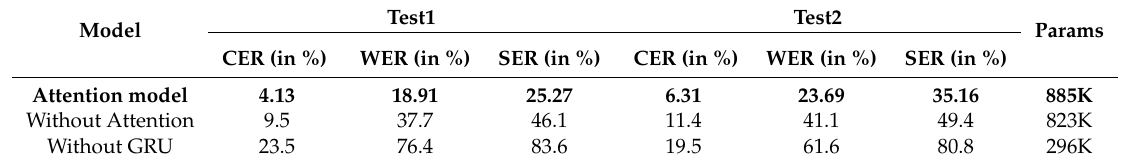
Table 3. The effect of attention mechanism on the HKR